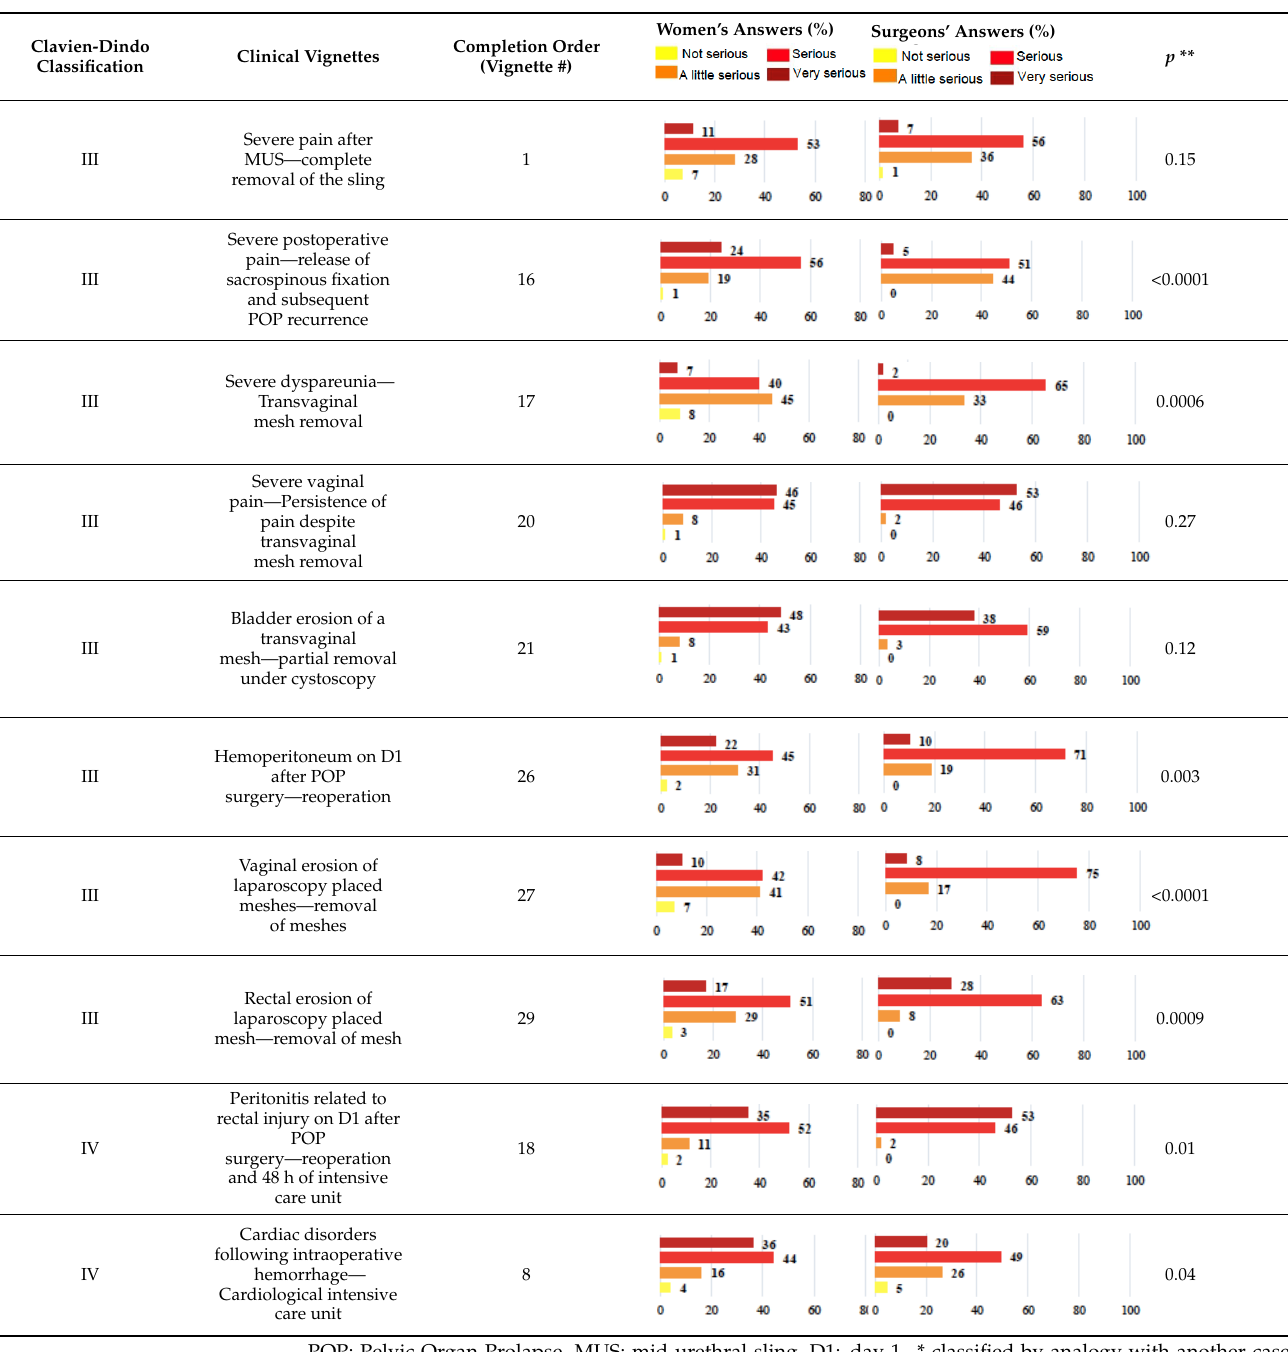
Table 2. Description and comparison of women’s and surgeons’ answers (percentages and Fisher’s exact test)—classifiable vignettes. Table 2. Cont.